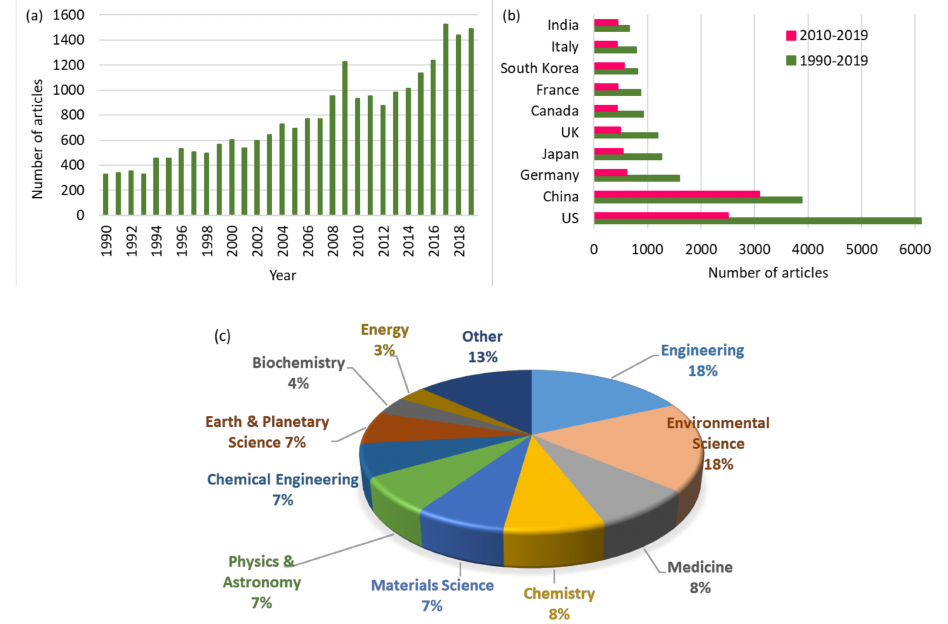
Figure1. Researchtrendssurveyedwithkeywordsof‘filter’and‘air’intheyears1990–2019. ( a )Number of journal articles; ( b ) Published articles by country; ( c ) Articles by subject area. The research analytics are sourced from